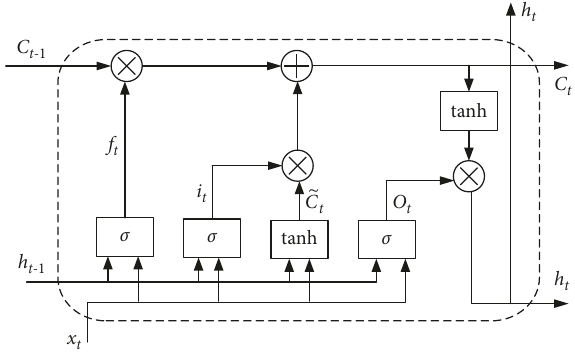
Figure 5: Structure of an LSTM